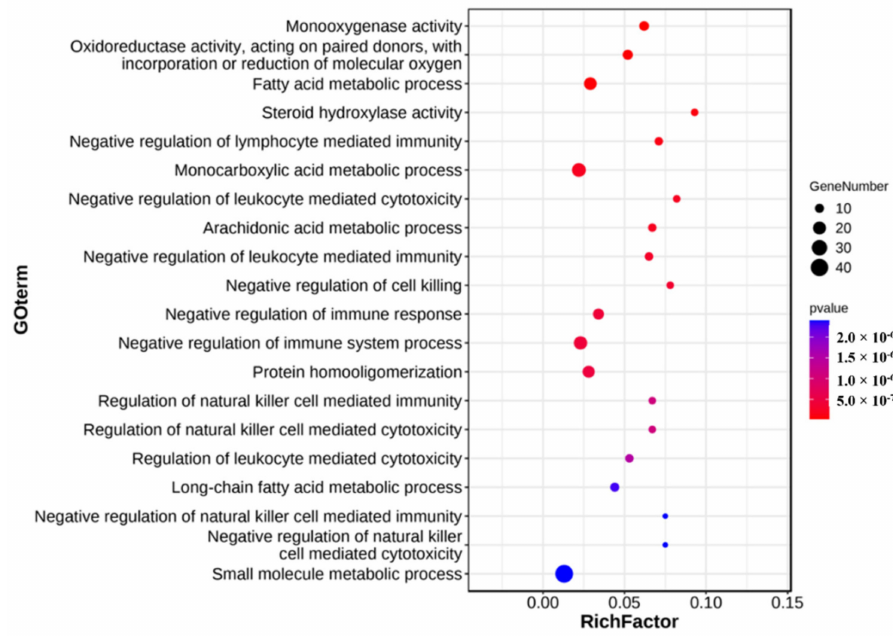
Figure 3. The top 20 GO terms with the most significant enrichment of DEGs.